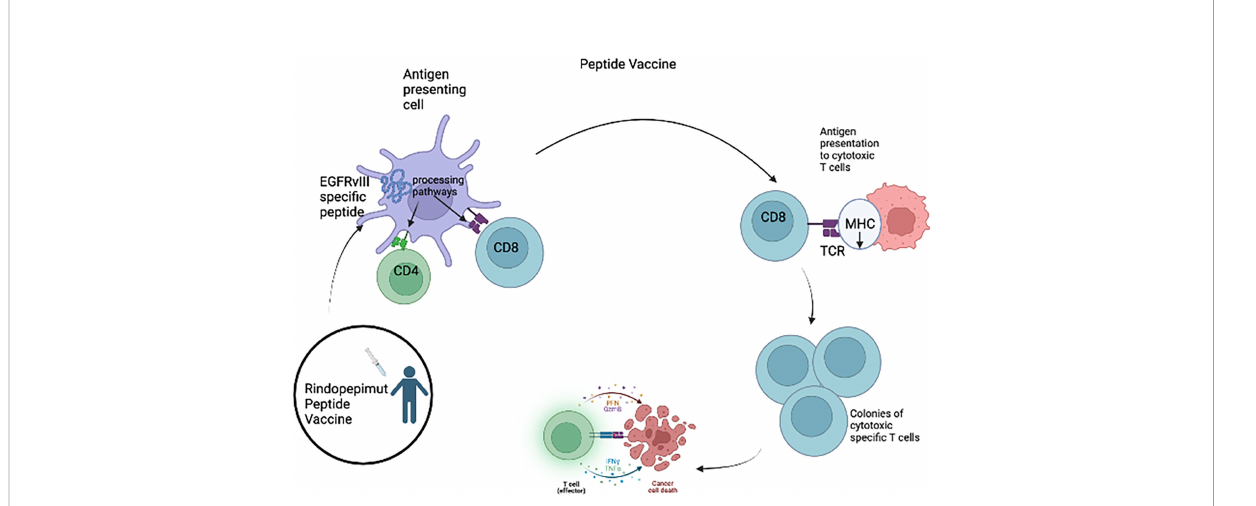
FIGURE 1 For the Rindopepimut vaccine, EGFRvIII speci fi c peptide is introduced into the bloodstream and the peptide is processed and presented by the APC causing the activation of CD4 helper T cells and CD8+ cytotoxic T cells. The cytotoxic T-cells are then able to cause lysis of the glioma tumor